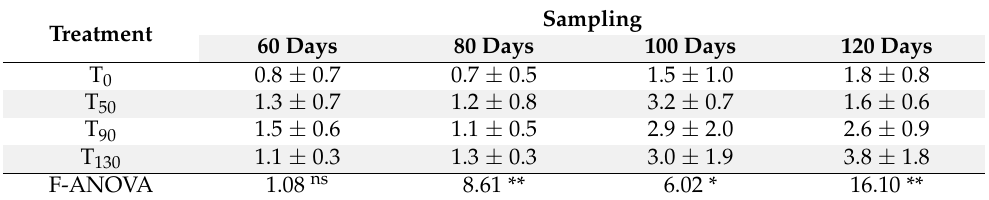
Table 9. Copper content ( µ g/L) in leachates. Entries represent means ± standard errors from n = 3 replicates.